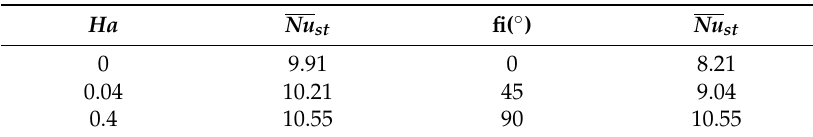
Figure 6. ( a ) The steady-state velocity and the Lorentz force distribution when Ha = 0.4; ( b ) effect of the Hartmann number ( Ha ) on temperature distribution; ( c ) effect of the Hartmann number ( Ha ) on the local Nussel number distribution along inner cylinder 1, 2 and 3, when φ = 0.01, β = 90 ◦ , Re = 1.0 and Le = 0.03. Table 5. Effect of Hartmann number ( Ha ) and the angle of magnetic field ( β ) on time and spatically averaged Nusselt number ( Nu st ).